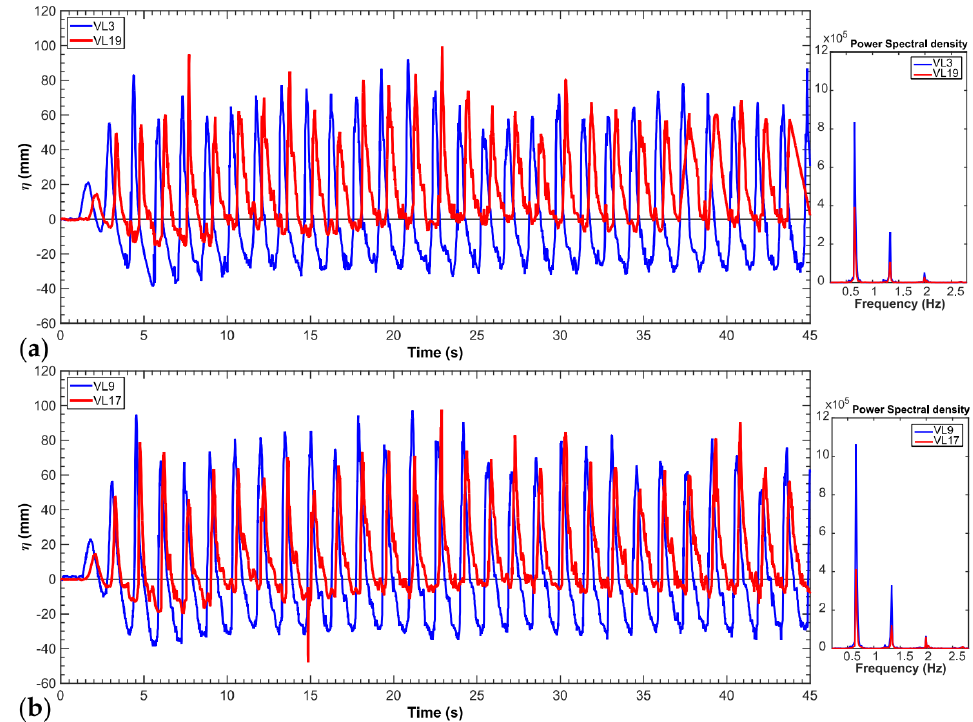
Figure 9. Comparisons of water elevations ( η ) measured before and after the interaction of the incident wave trains with the structure, including the power spectral density of the signals: ( a ) com- parison of VL3 (located at the beginning of the horizontal image domain) with VL19 (located at the end of the domain); ( b ) comparison of VL9 (located close to the structure, before the top) with VL17 (located close to the structure, after its